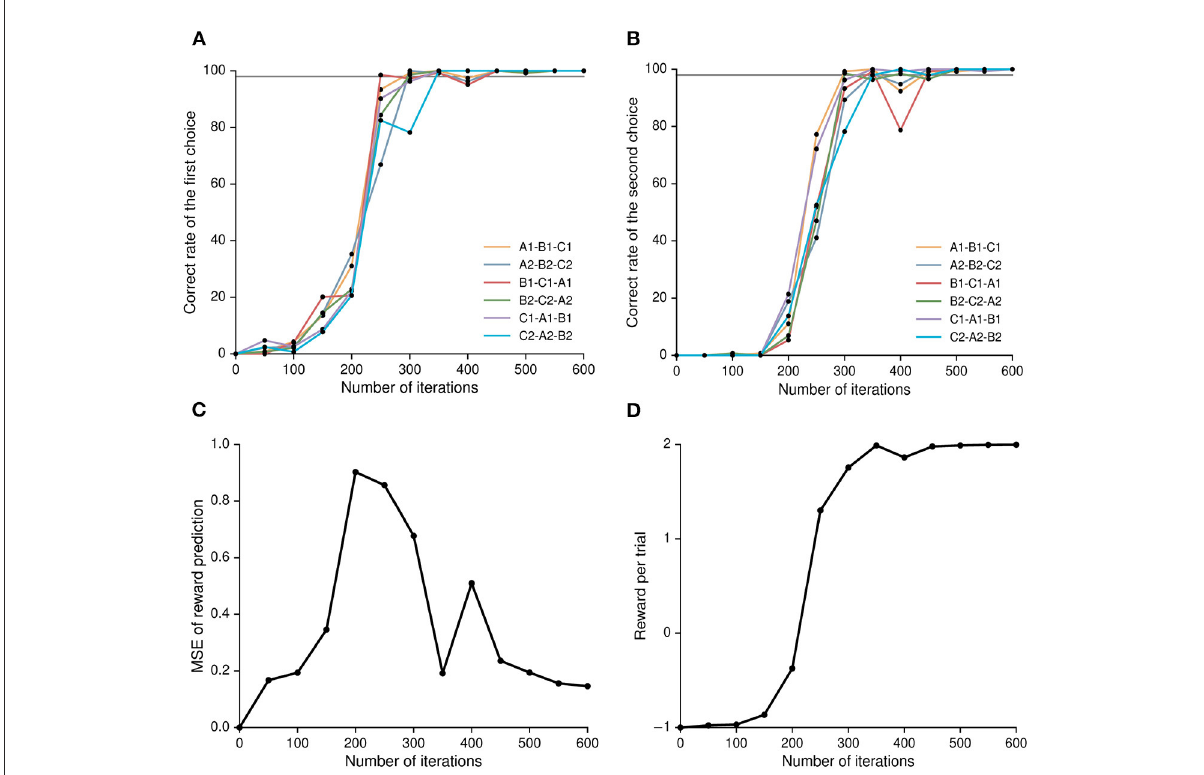
FIGURE3 Behavior performance of the deep RL model. (A) Correct rate of the first decision period (the ratio of correct choice trials in the first decision period to all trial) for each stimulus-stimulus associations. (B) Correct rate of the second decision period (the ratio of correct choice trials in both decision periods to all trials) for each stimulus-stimulus associations. Here, the gray line denotes 98% of the target value. (C) The mean square error (MSE) of reward prediction for the network model in the second decision period (see Equation 14). Mean square error between the actual reward (based on the selected action in the policy network) and the predictive reward (estimated in the value network). (D) The reward obtained by the network model per